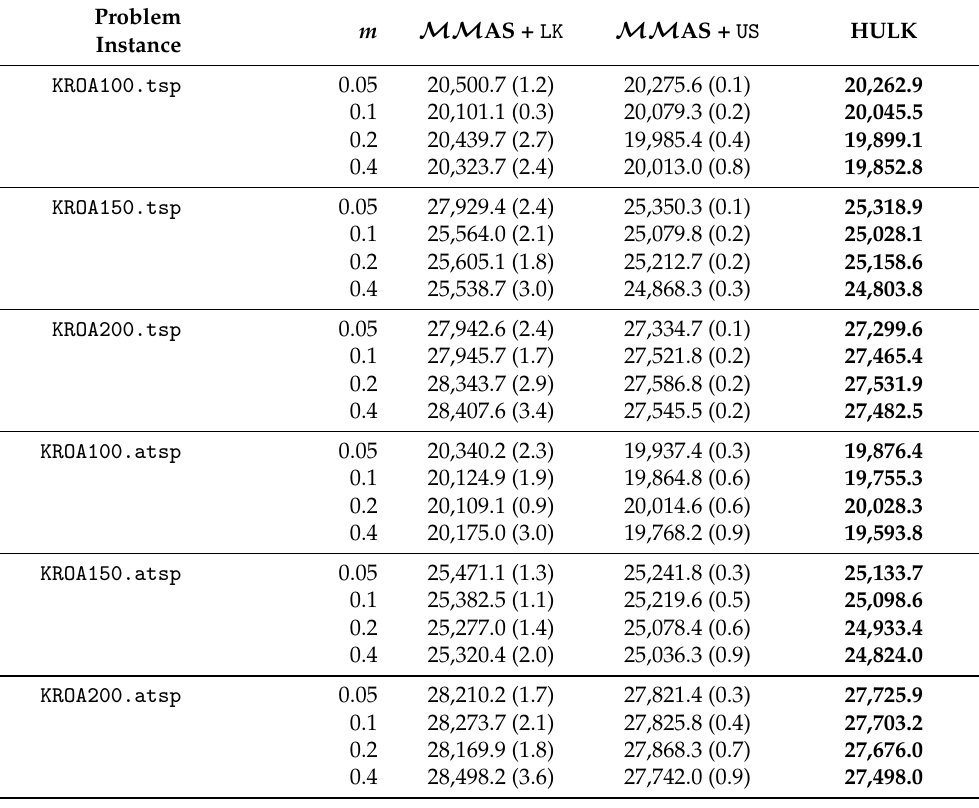
Table 1. Experimental results regarding the average offline performance of the presented methods on symmetric DTSPs (upper half) and asymmetric DTSPs (lower half) for instances from KROA family without arc blocking. The number between brackets means the distance in percentage from the current value to the best value, in boldface.